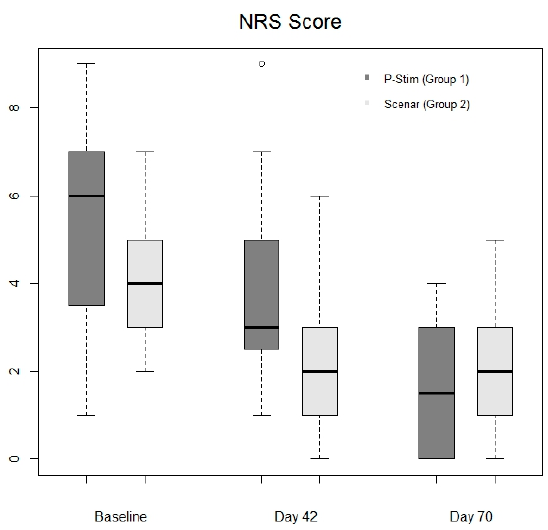
Figure 4. Comparison of pain intensity measured by numerical rating scale (NRS).